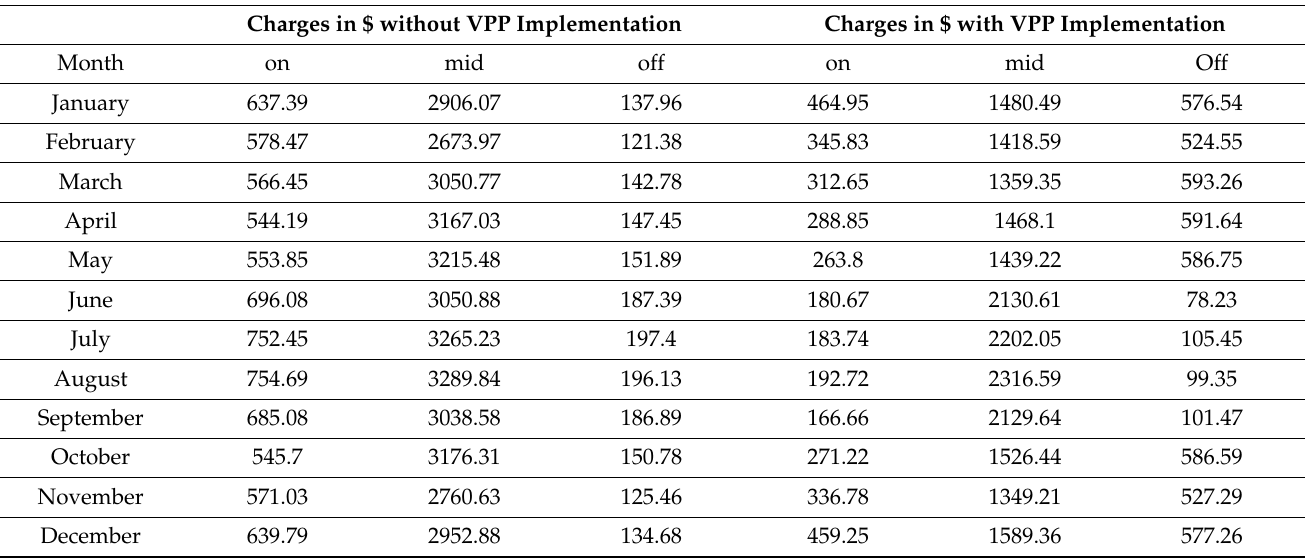
Table 4. Monthly savings in energy charges.